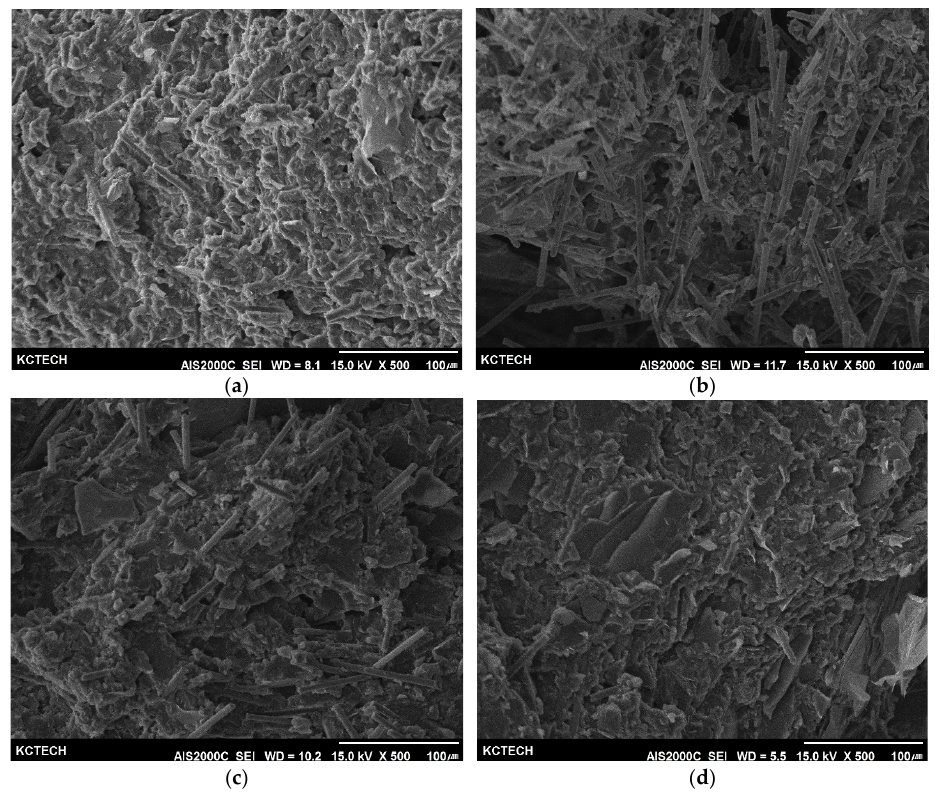
Figure 6. Cross-section SEM images of the composites with different mixing ratios of polypropyl- ene:carbon fibers:graphite flake; ( a ) 100:40:10, ( b ) 100:30:20, ( c ) 100:20:30, ( d ) 100:10:40.